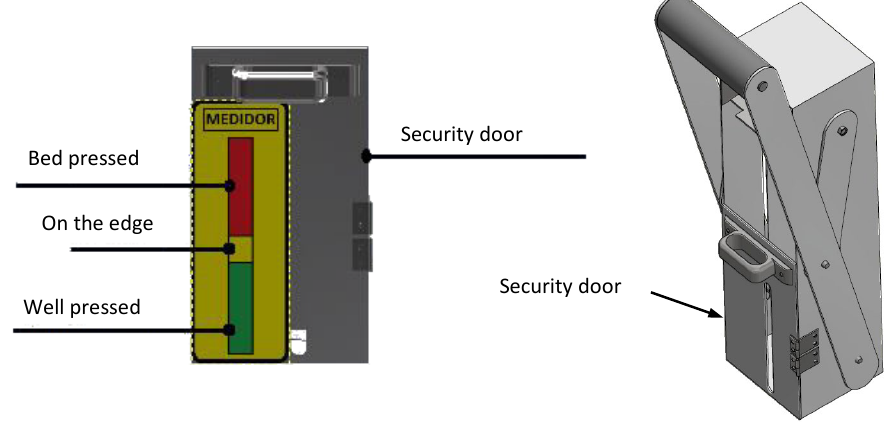
Figure 9. Compression level and security door [46].